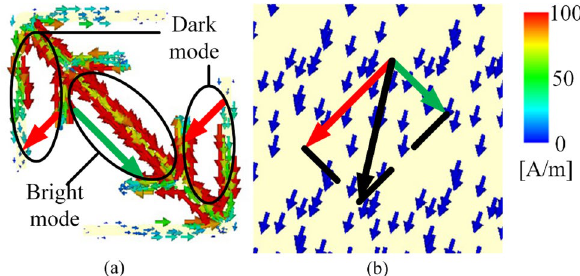
Figure 5. Surface current distributions of top metal pattern (a) and surface current distributions of bottom background sheet (b) at the fifth resonance frequency of 13.30 GHz.